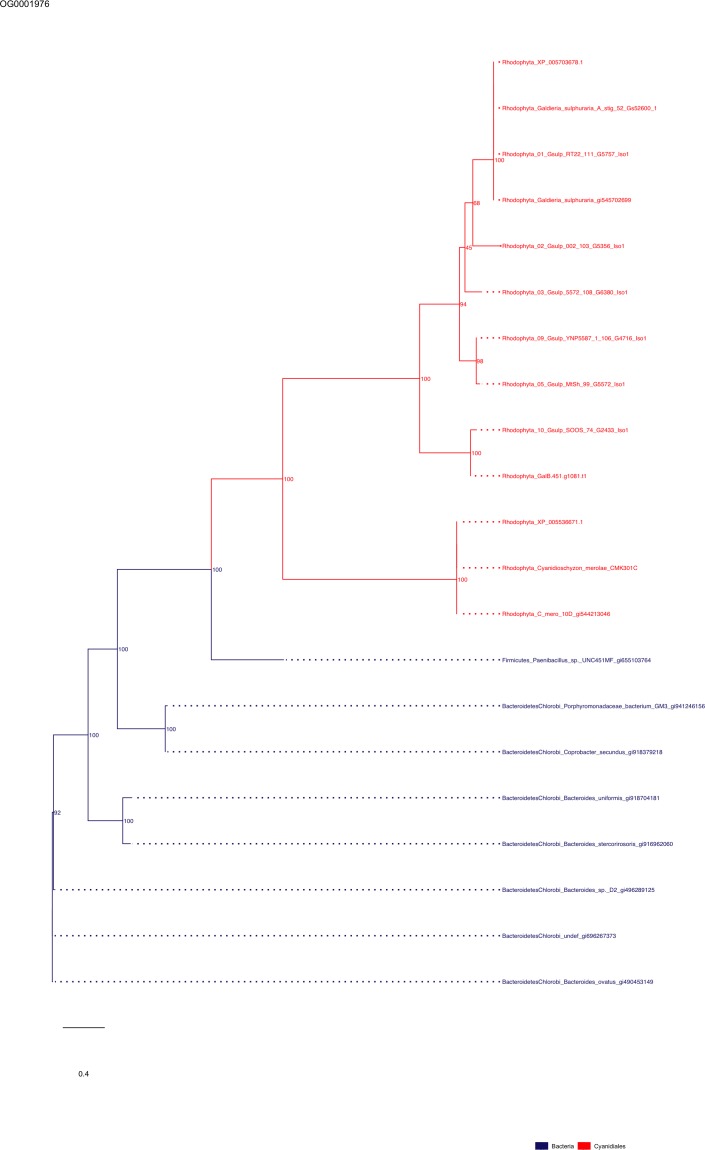
Sequence tree of orthogroup OG0001976.The tree is based on amino acid sequences. Archaea (yellow), Bacteria (blue), Cyanidiales (red), Eukaryotes including other red algae (green). Branches containing Cyanidiales sequences are highlited in red.